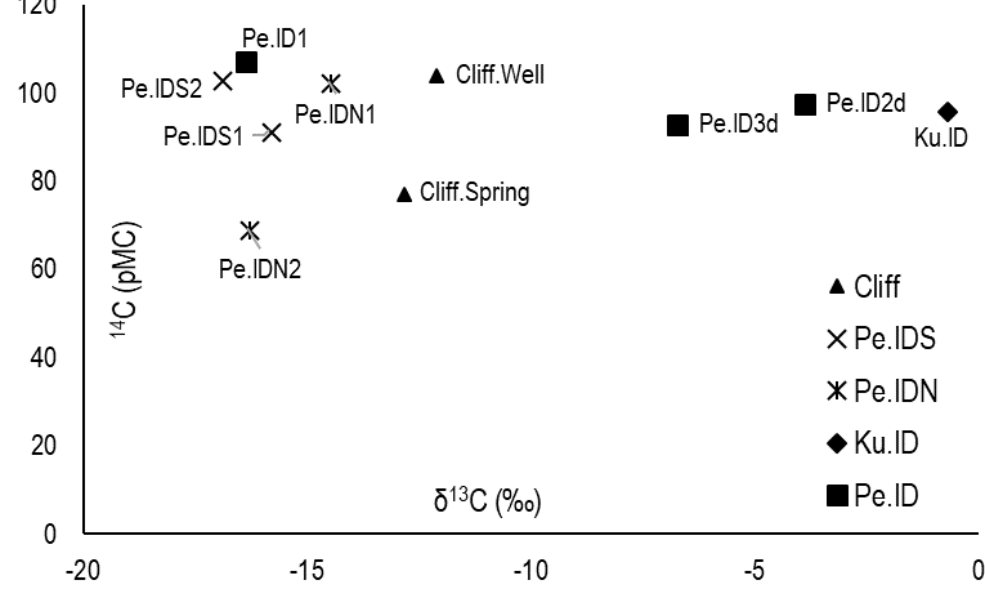
Figure 6. Radiocarbon 14 C (pMC) content plotted against the stable carbon isotope δ 13 C (‰) content in eleven groundwater samples from Slitere National